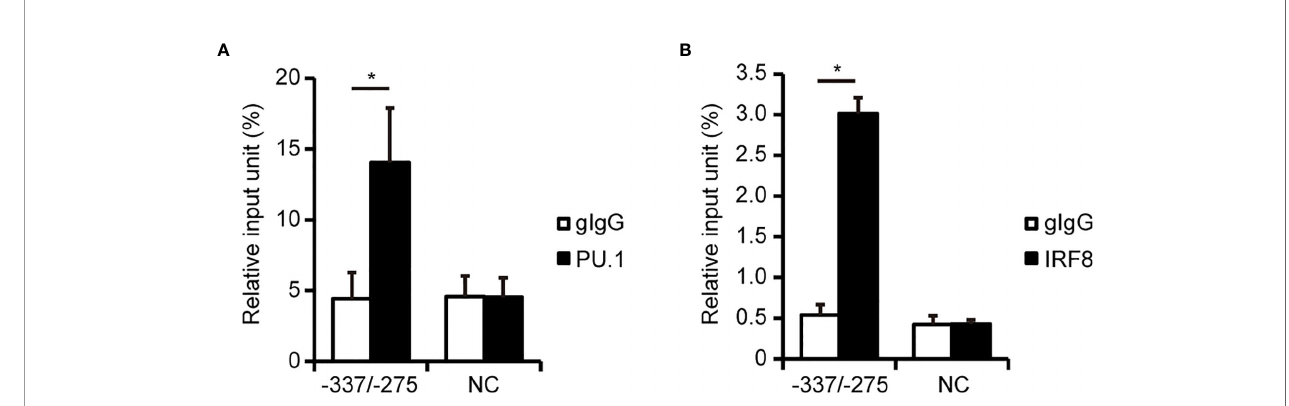
FIGURE 4 | PU.1 and IRF8 bind to the hNLRP3 promoter in THP-1 cells. (A, B) THP-1 cells were subjected to ChIP assays using anti-PU.1 antibody (PU.1) (A) , anti-IRF8 antibody (B) , or goat IgG (gIgG). Coimmunoprecipitated DNA was quanti fi ed by qPCR with primers amplifying the indicated regions of the hNLRP3 promoter. Data are presented as the mean + S.D. ( n = 3). * p < 0.05, two-tailed student ’ s t